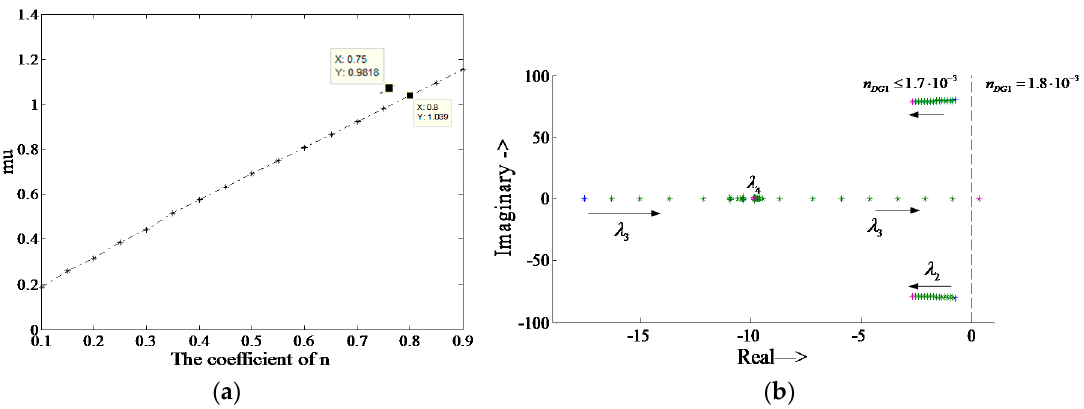
Figure 15. ( a ) Value of µ ∆ ( G MG ( s )) with size coefficients λ n _ DG 1 and m = 22 × 10 − 4 . ( b ) Dominant eigenvalues for the MG with 0 ≤ n ≤ 1.8 × 10 − 3 and m = 22 × 10 − 4 .